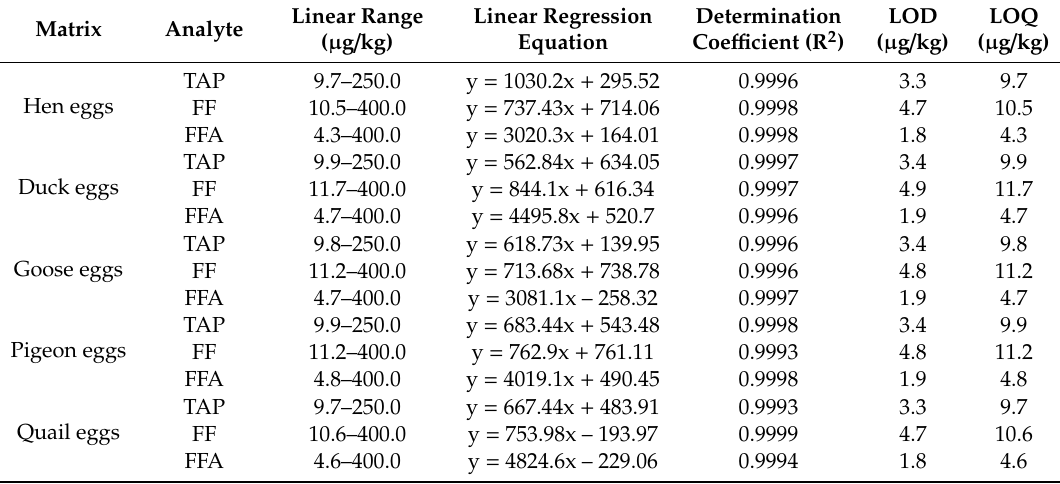
Table 3. The linear ranges, linear regression equations, determination coefficients, LODs and LOQs of TAP, FF and FFA from poultry eggs.